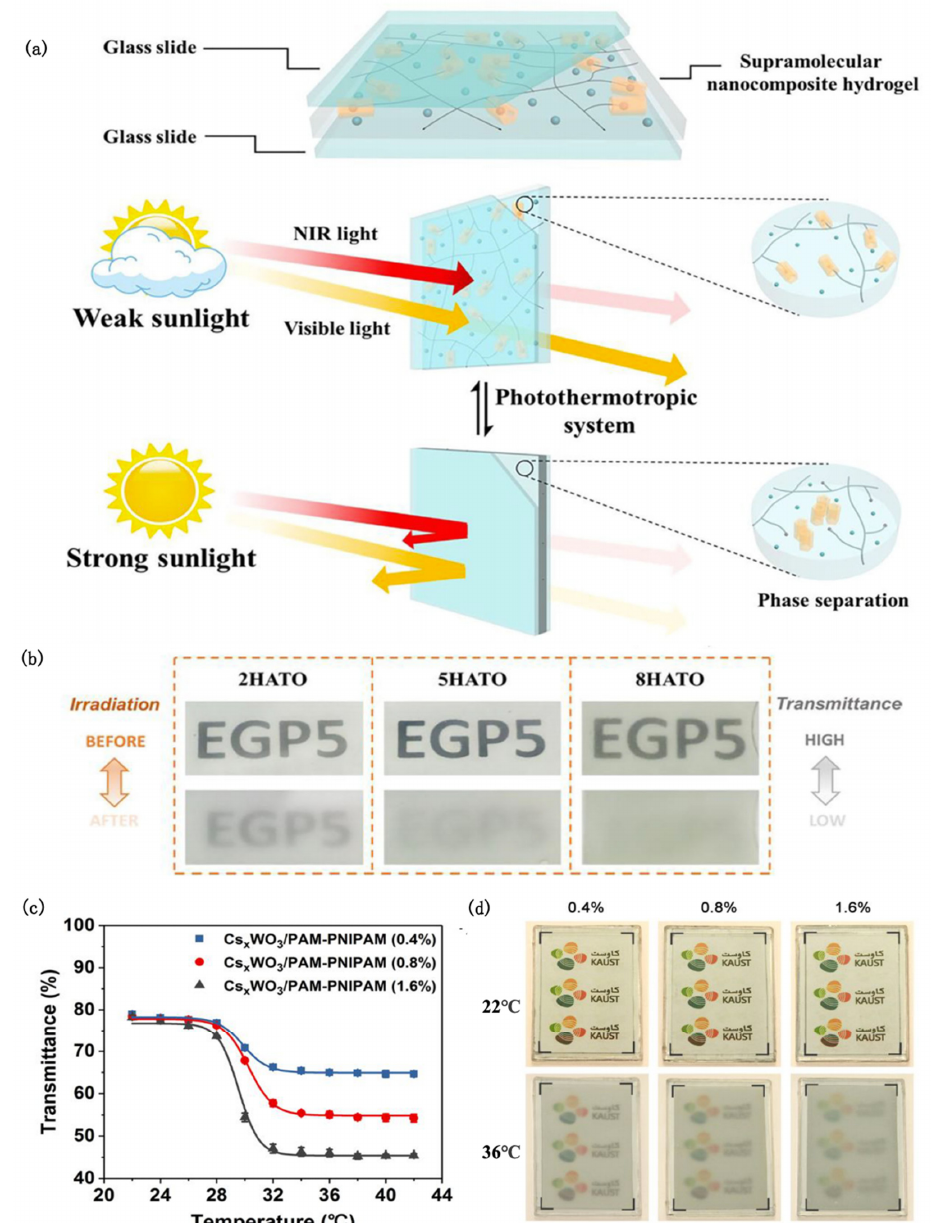
Figure 4. ( a ) Schematic diagram of the chemical structure and working principle of the photochromic supramolecular hydrogel smart window [73]. ( b ) Photographs of ATO composite hydrogel films with EGP5 contents of 2, 5, and 8 mol%, respectively, before and after irradiation at 100 mW/cm 2 for 10 min [73]. ( c ) Transmittance variation of Cs x WO 3 /PAM-PNIPAM film with temperature at 550 nm wavelength [74]. ( d ) Transparency changes of Cs x WO 3 /PAM-PNIPAM films with different PNIPAM concentrations at 22 ◦ C (above) and 36 ◦ C (below)